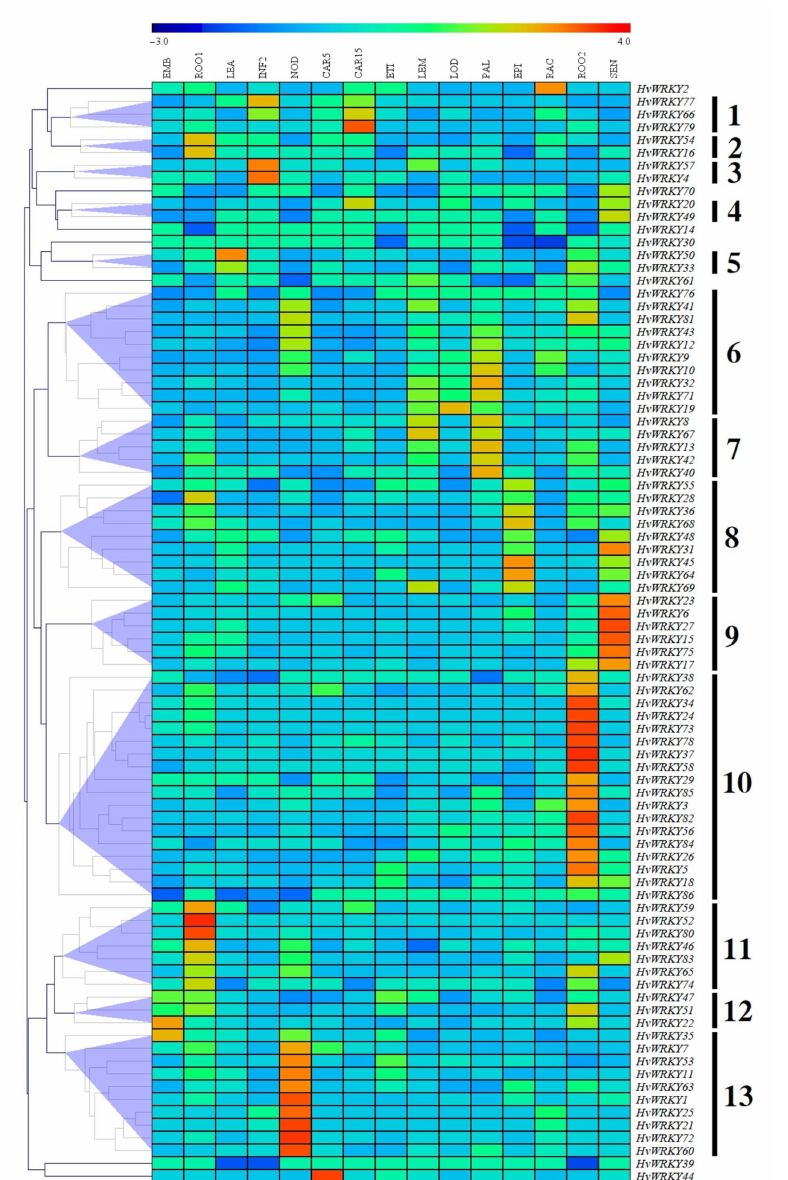
Figure 7. The relative transcription level of the HvWRKY genes in different growth stages and tissues. Blue represents lower expression, red represents higher expression, and the number on the right represents the groups of expression patterns. The sample sources are as follows: EMB: 4 day embryos; ETI: etiolated seedling, dark condition (10 DAP); ROO1: roots from seedlings (10 cm shoot stage); LEA: shoots from seedlings (10 cm shoot stage); EPI: epidermal strips (28 DAP); INF2: developing inflorescences (1–1.5 cm); RAC: inflorescences, rachis (35 DAP); ROO2: roots (28 DAP); NOD: developing tillers, 3rd internode (42 DAP); LOD: inflorescences, lodicule (42 DAP); LEM: inflorescences, lemma (42 DAP); PAL: dissected inflorescences, palea (42 DAP); CAR5: developing grain (5 DAP), CAR15: developing grain (15 DAP); SEN: senescing leaves (56